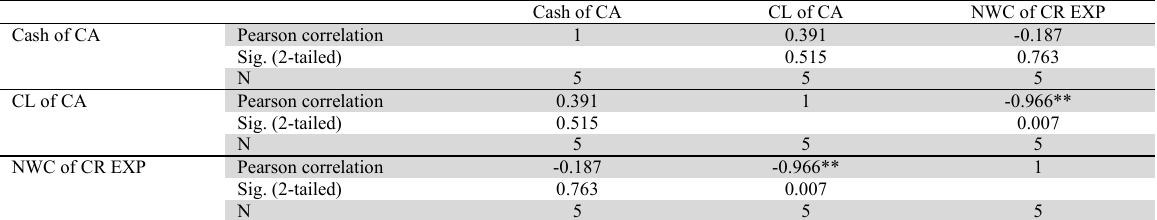
Correlation analysis of retail